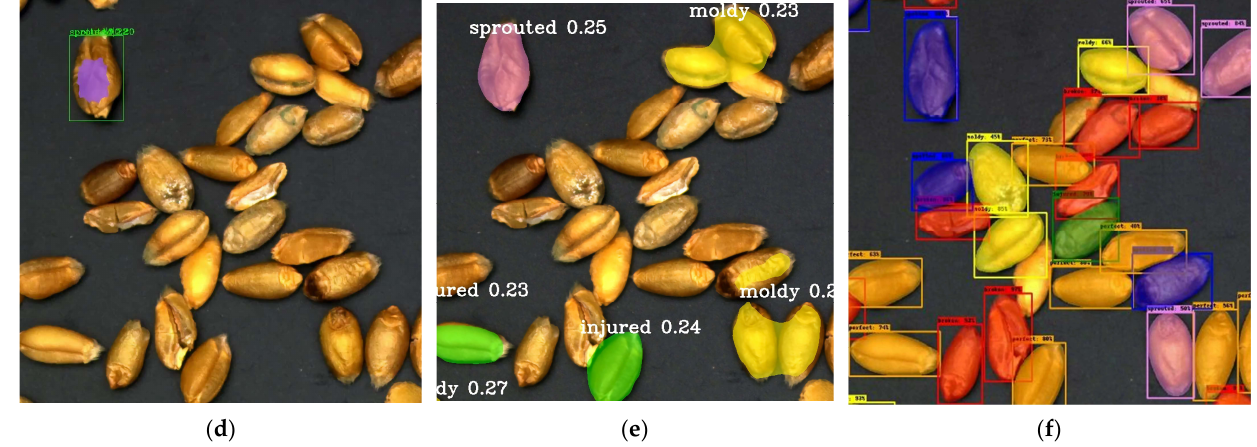
Figure 10. Result images with detailed information. ( a ) Original image. ( b ) Result images of Swin Transformer. ( c ) Result images of mask scoring RCNN. ( d ) Result images of polar mask. ( e ) Result images of SOLO. ( f ) Result images of ours (representations of color boxes are as follows: orange: perfect kernels; yellow: moldy kernels; red: broken kernels; purple: sprouted kernels; blue: spotted kernels; green: injured kernels).